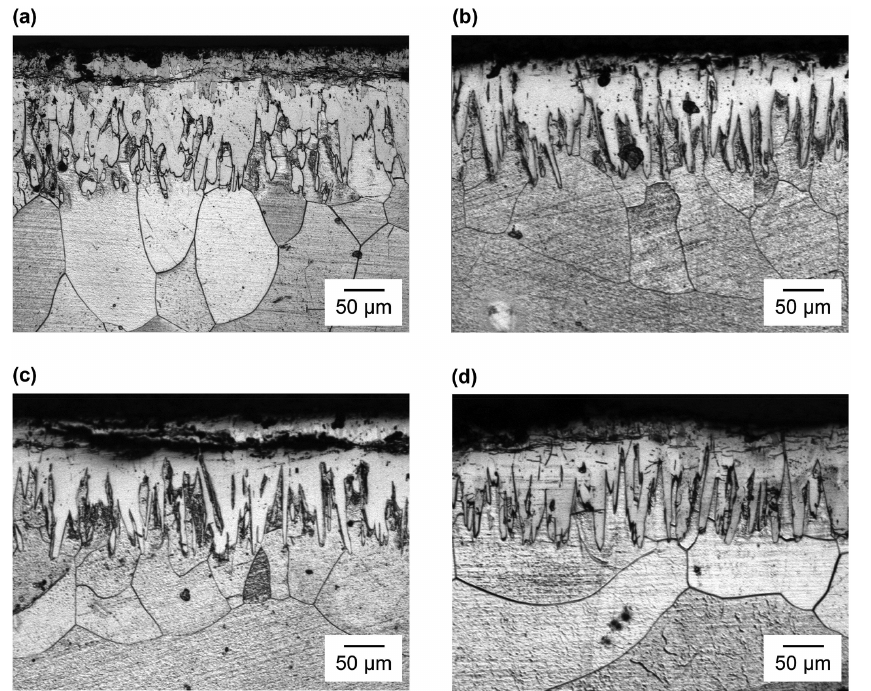
Figure 1: Cross-sectional optical microscopy images of pure Fe borided at 1,173 K for 4 h using (a) ZB1, (b) ZB2, (c) ZB3 and (d) ZB4